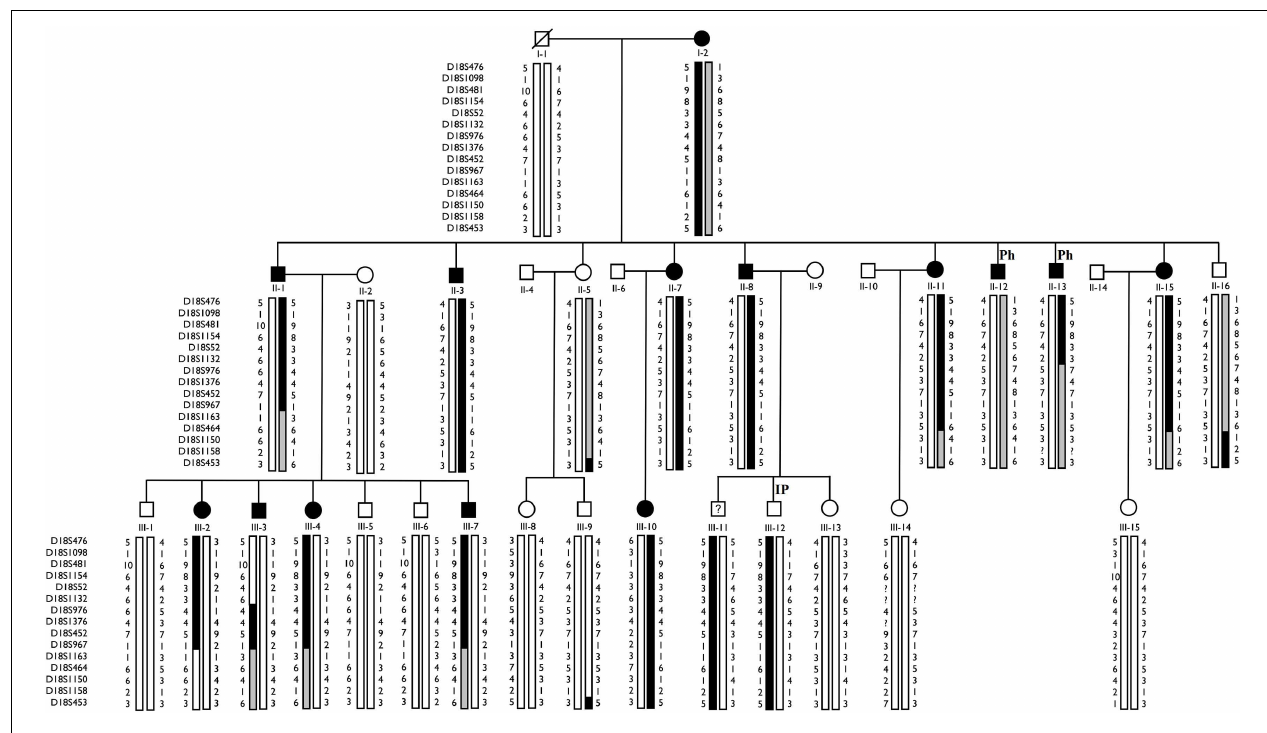
not participate in the linkage study are not shown. Individual III-3 shows a critical recombination event. IP, Incomplete Penetrance; Ph, Phenocopy.